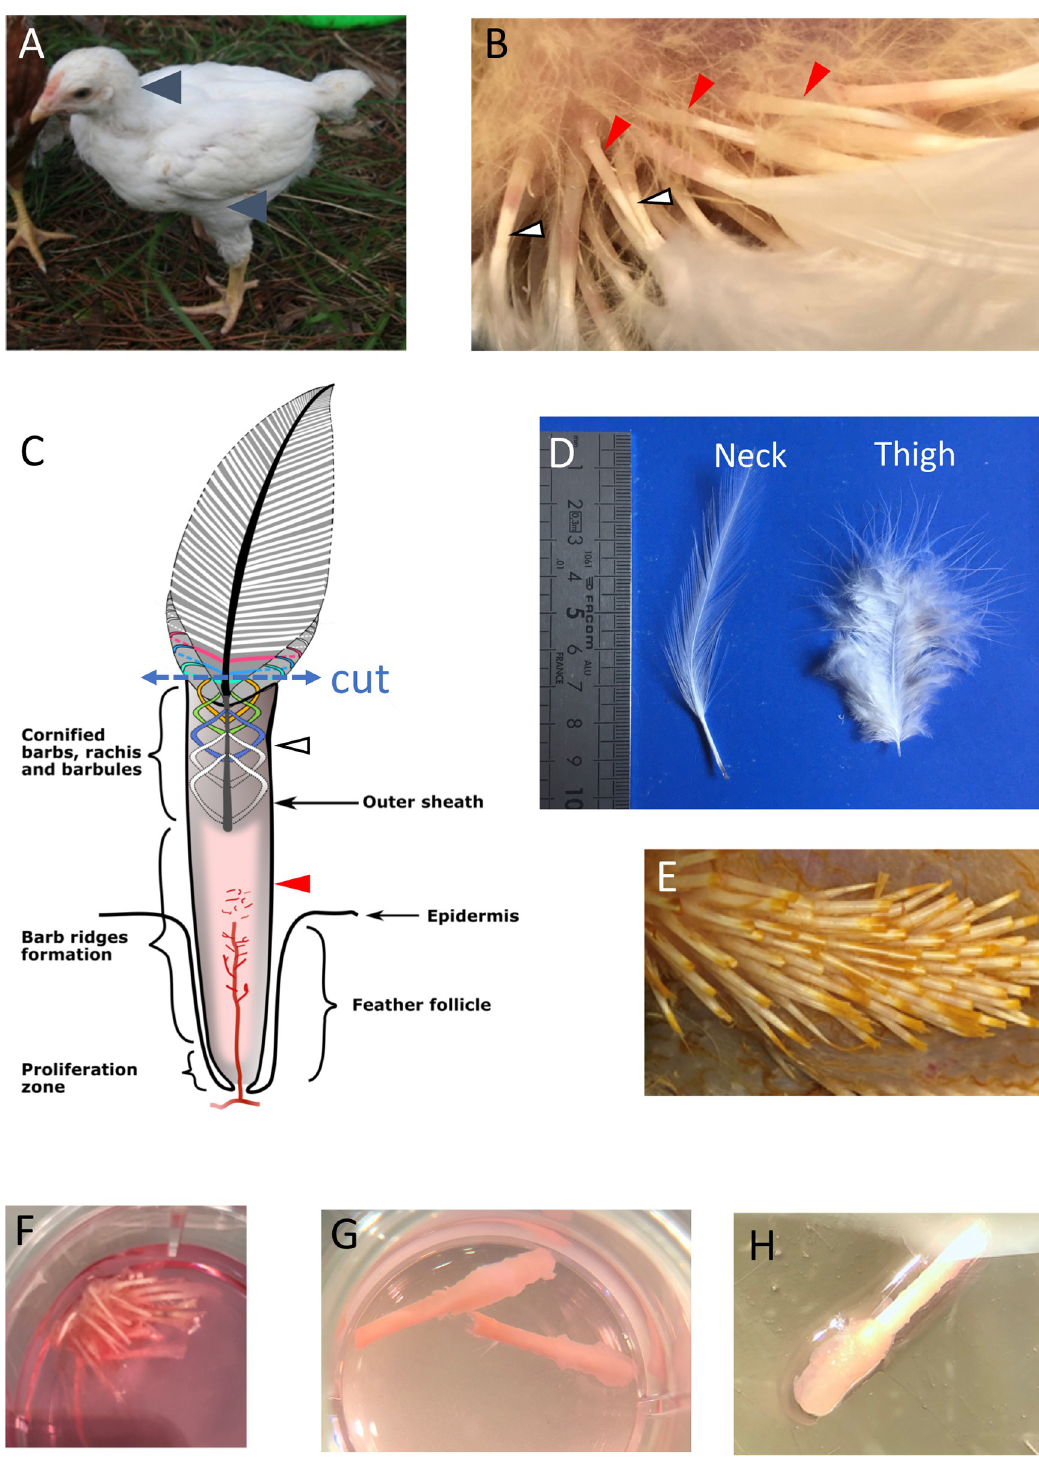
Fig 2. Steps to obtain individual feather follicles for in vitro culture. In 3-week old White Leghorn chick (A), the contour feathers from two regions (blue arrowheads) (the base of the neck or the thigh) have reached a developmental stage (B, C) before becoming adult contour feathers (D). Note that feathers are heterogenous in their development (B), with feathers just popping-out the outer sheath (red arrowhead) or feathers close to their terminal size. The white zone (white arrowheads) corresponds to cornified rachis containing barbs and barbules (devoid of pulp), which are limited by the outer sheath (B, C); in contrast the